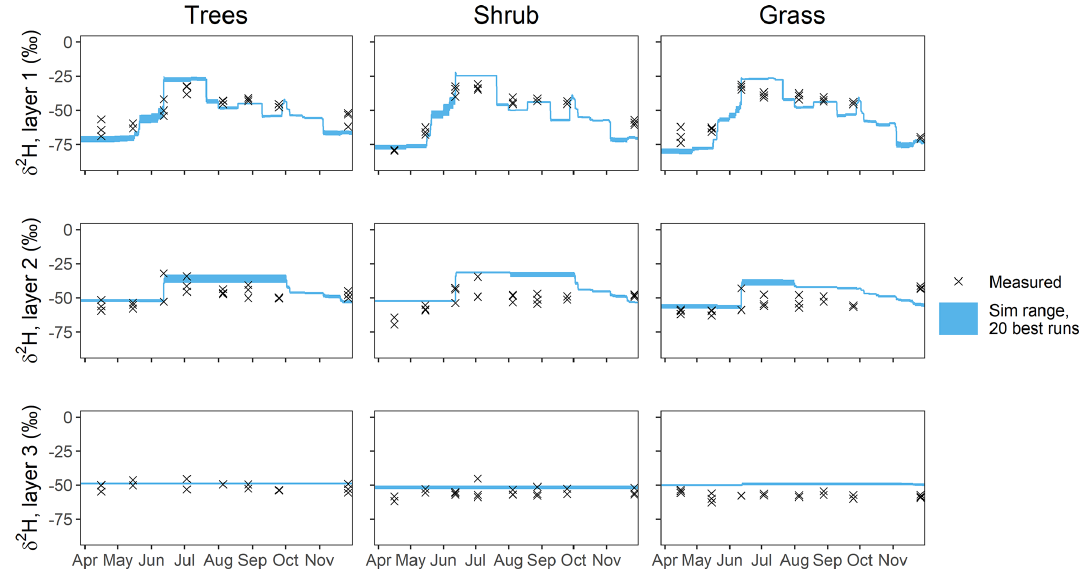
Figure 6. Measured and simulated stable water isotope δ 2 H in bulk soil water. KGE values given for layer 1. Table 2. Simulated cumulative water balance component transpiration, interception evaporation, soil evaporation, total evapotranspiration (ET) and infiltration. Median and standard deviation of 20 best runs.